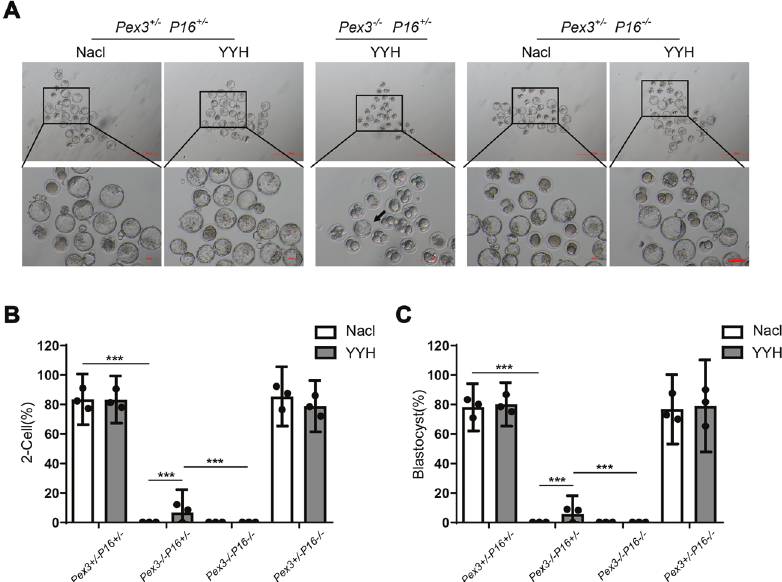
Fig. 7 Effects of YYH treatment on early embryonic development in mice with different genotypes. ( n = 3). A Contrast images of blastocyst-stage embryos from each group. Scale bars: 100 μ m. B Two-cell embryo rate. C Blastocyst